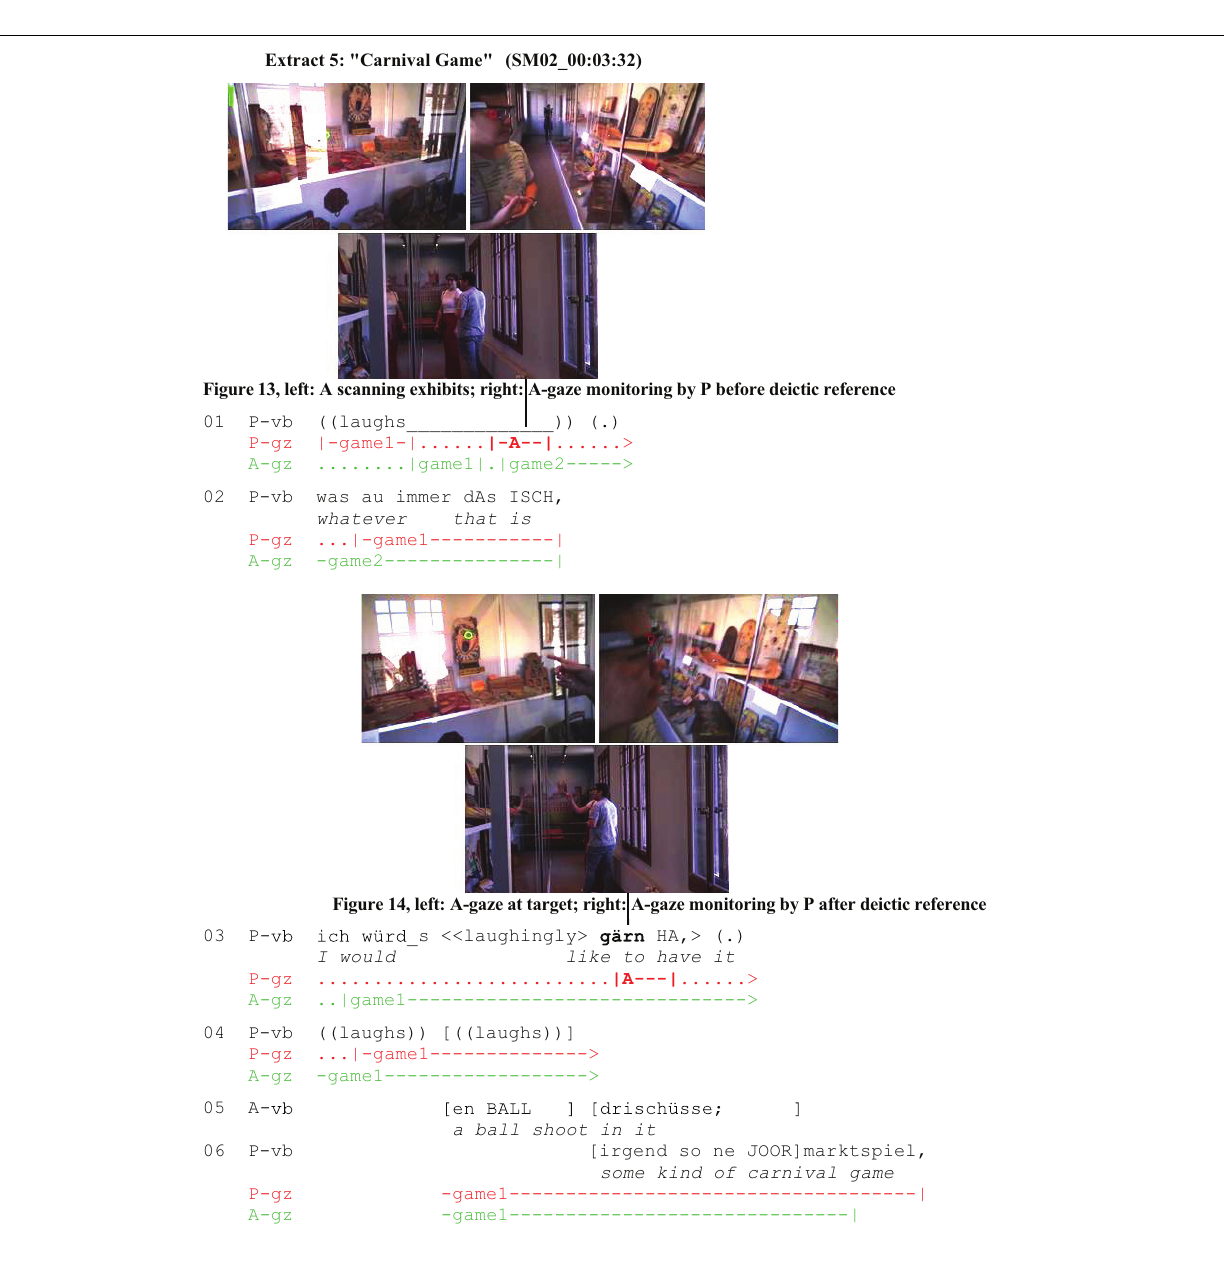
Figure 14, left: A-gaze at target; right: A-gaze monitoring by P after deictic